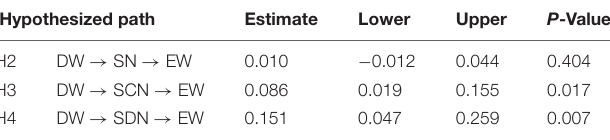
TABLE 4 | Bootstrap analysis of mediating effect test.